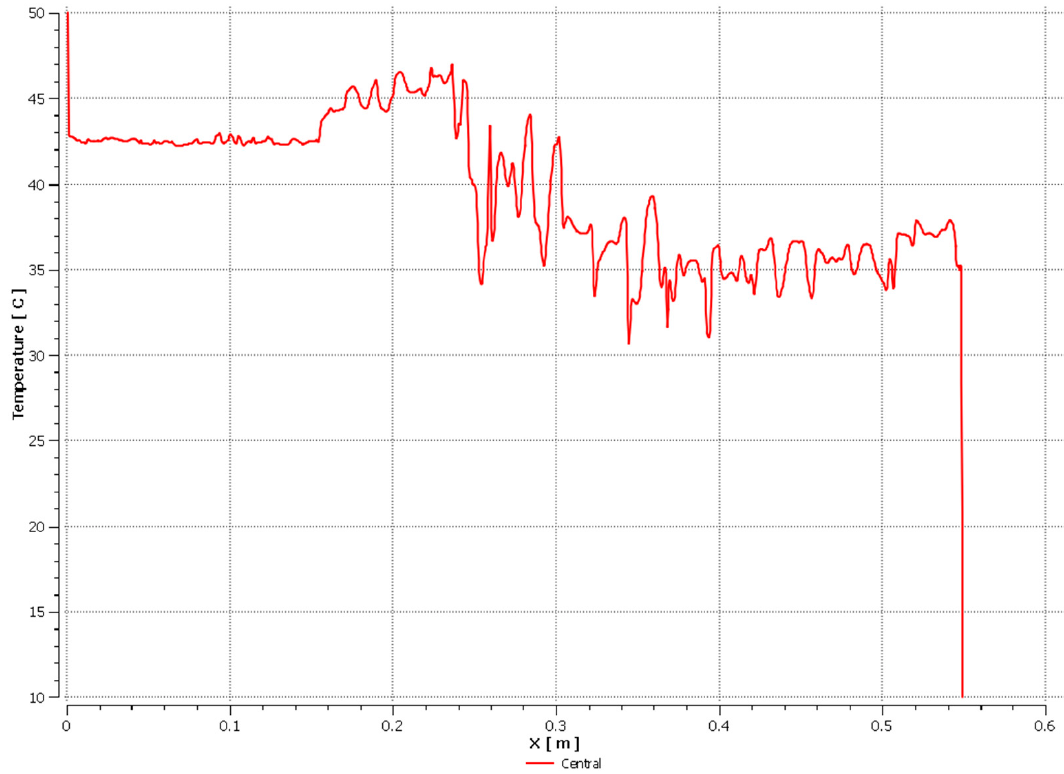
Figure 34. Temperature distribution along the height of the heat pipe’s central line.